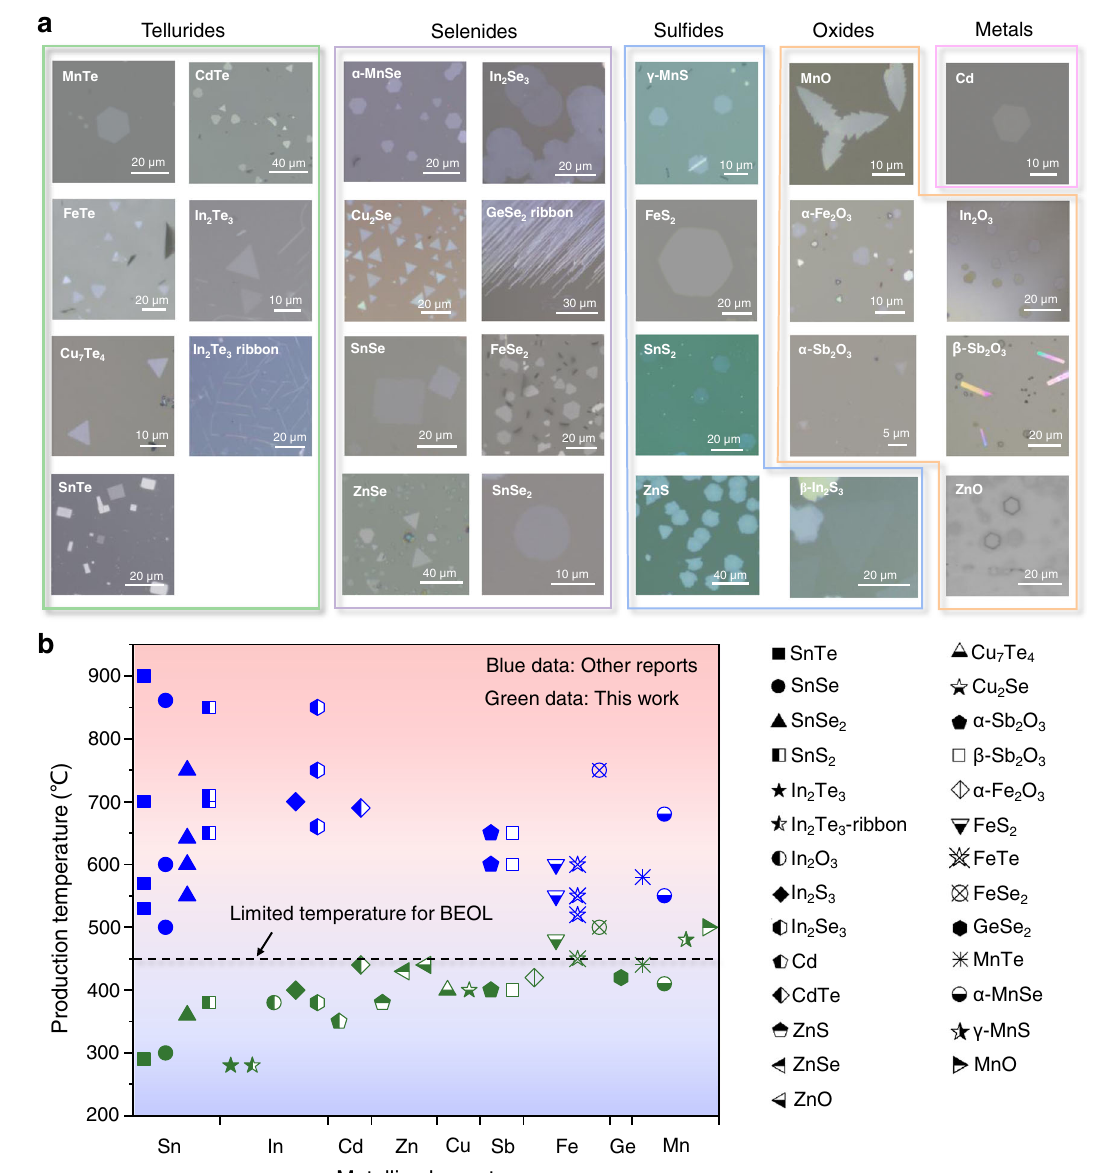
β -In α -Fe α -Sb β -Sb 2 S 3 ), oxide (MnO, 2 O 3 , 2 O 3 , 2 O 3 , ZnO, In 2 O 3 ), metal (Cd). b Comparison of synthesis temperature of the material library with other reports. Limited temperatureis450°C for BEOL. The blue data isother reports, green data is this work. Detailed references are shown in Supplementary Table